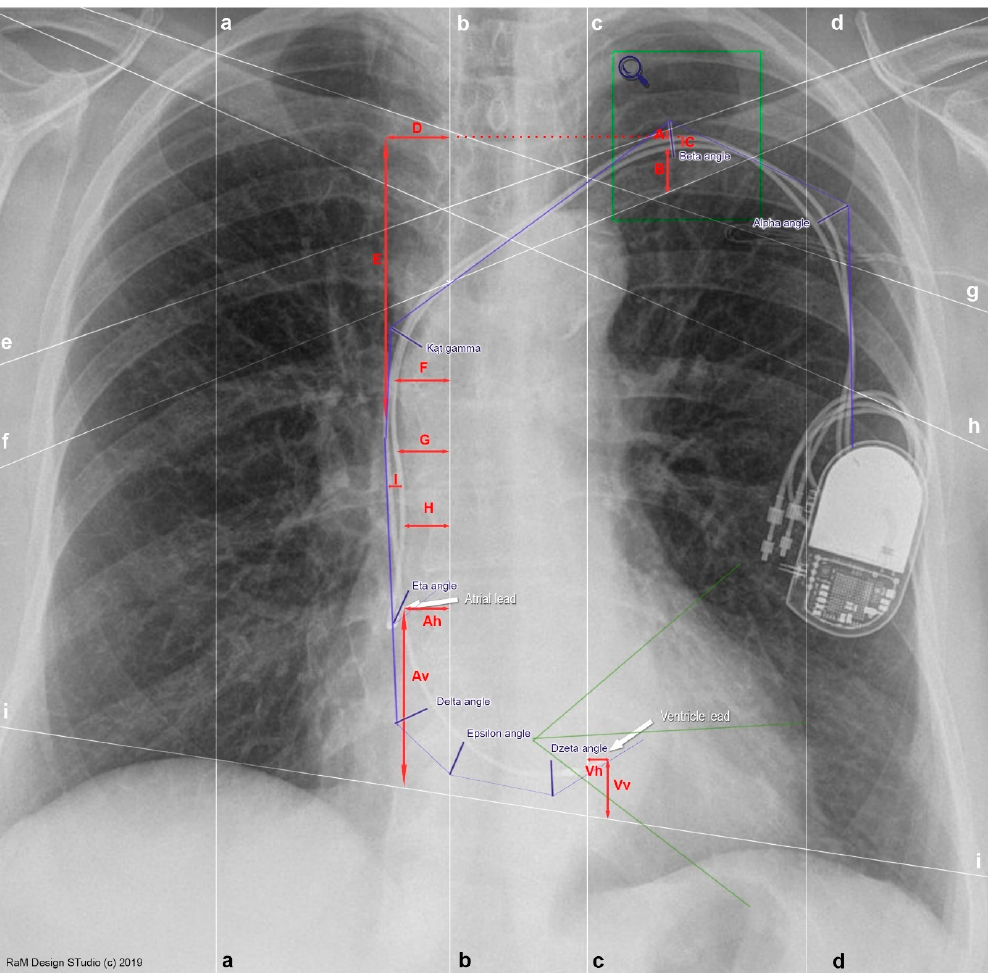
Figure 1. Measurements used in the research based on an example of an X-ray image in a PA (posterior–anterior) projection. ( a ) Midclavicular line—right; ( b ) Lateral sternal line—right; ( c ) Lateral sternal line—left; ( d ) Midclavicular line—left; ( e ) Upper clavicular line—left; ( f ) Lower clavicular line—left; ( g ) Upper clavicular line—right; ( h ) Lower clavicular line—right; ( i ) Diaphragm dome line. Red letters are explained in Appendix A, Table